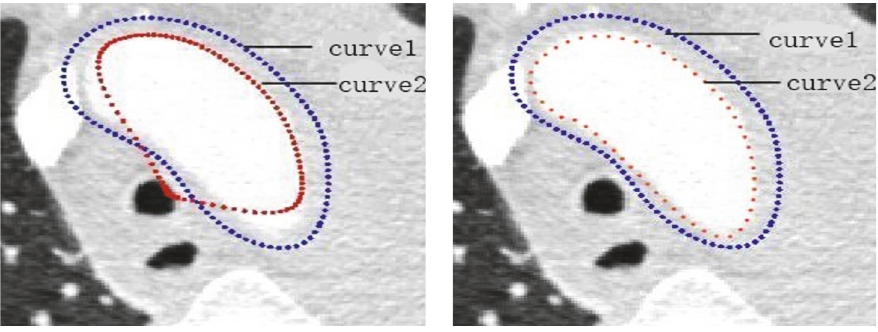
Figure 11: Iteration results based on two